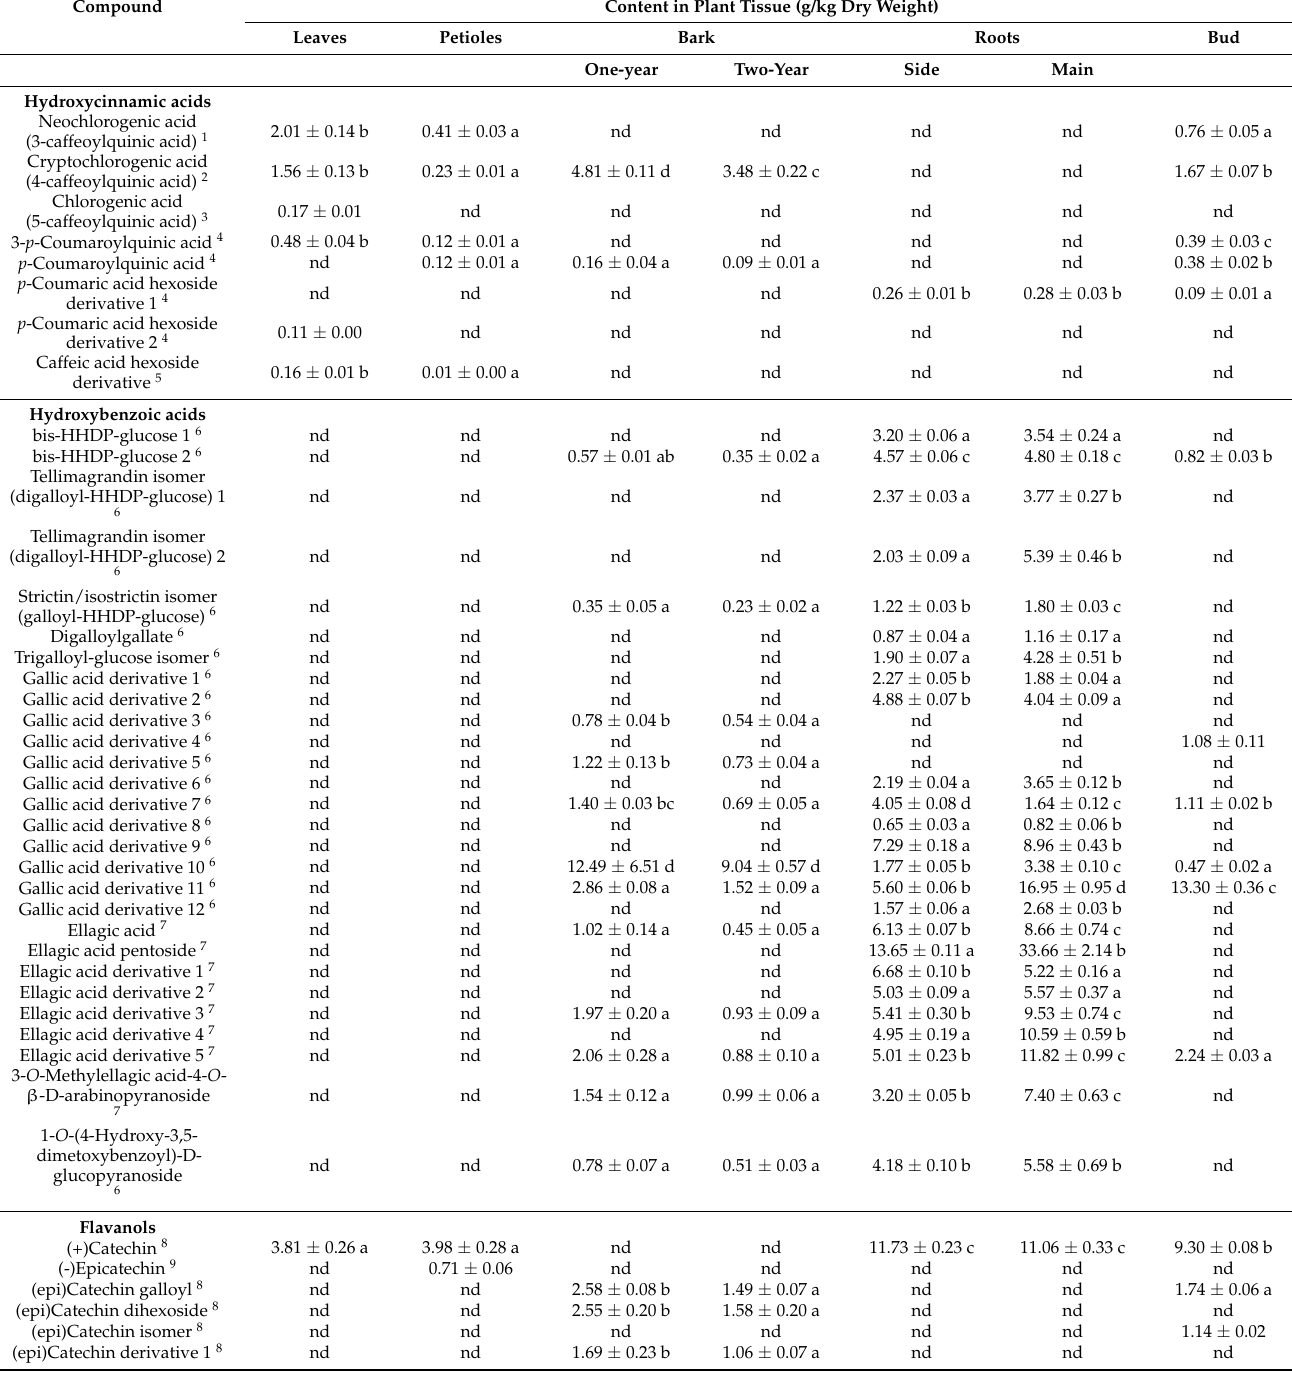
and flavonols for buds (Figure 2B). The total naphthoquinones were the major phenolic group in leaves, petioles, bark, and buds, where they represented >60% of the phenolic compounds identified; conversely, hydroxybenzoic acids were the major phenolic group in side roots, at ~50% of the phenolic compounds identified. The total phenolic compounds in roots was higher than any previously reported for J. regia kernel [1], husk [5], leaves [22], shoots [24], bark [5], or buds [5], which further justifies the use of roots as a valuable source of phenolic compounds; instead, the use of petioles cannot be justified. The contents of the total and individual phenolic compounds in each of the tissues analyzed here are given in Table 2. Table 2. Contents of the 91 phenolic compounds identified in the J. regia leaves, petioles, bark, roots, and buds. Compound Content in Plant Tissue (g/kg Dry